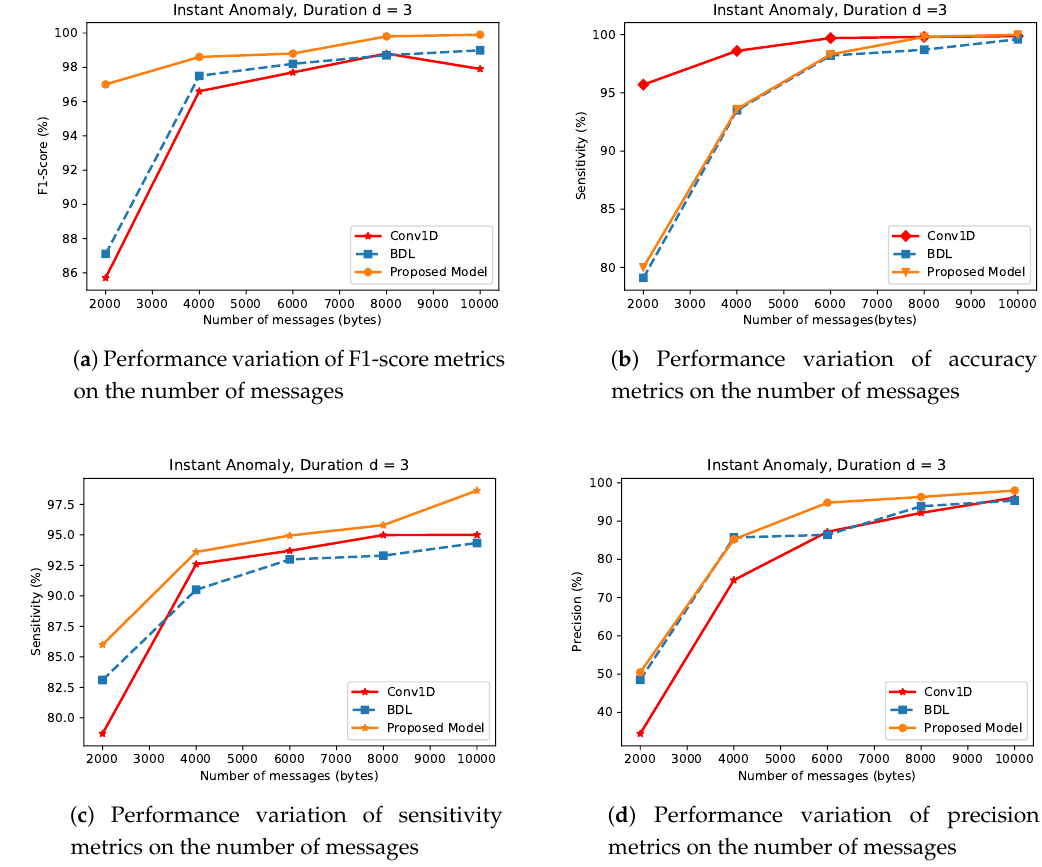
Figure 9. Detection Performance of Instance Anomaly type for Convolutional Neural Network (CNN), Bayesian Deep Learning (BDL) and the Proposed